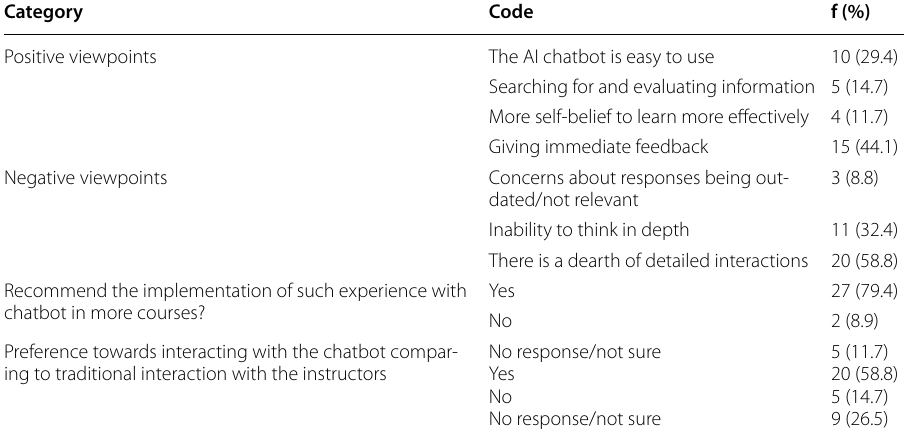
Table 7 Thematic codes generated from 34 students’ evaluation of their interaction with the KNUSTbot